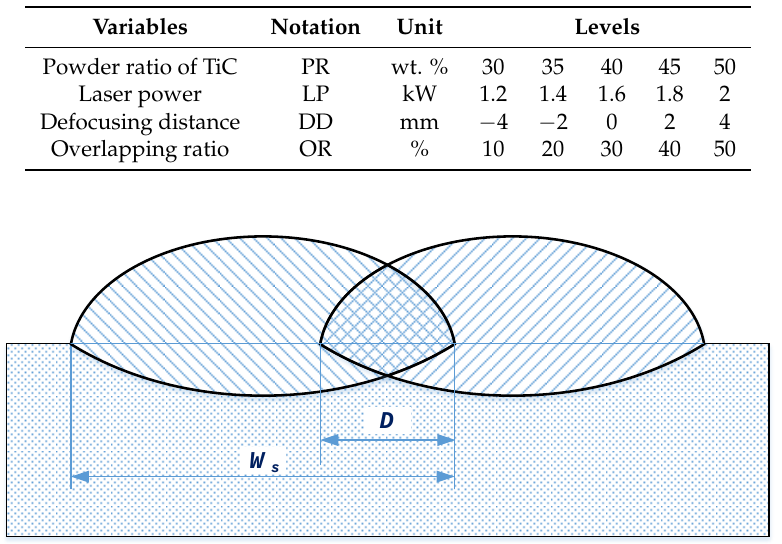
Figure 3. Schematic diagram of overlapped passes.